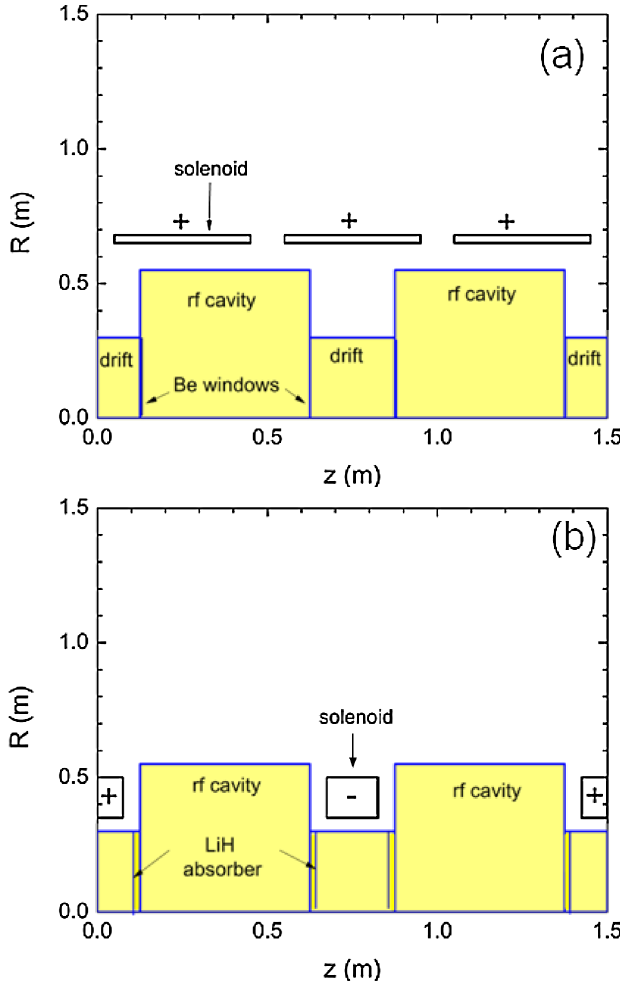
FIG. 2. Two cells of the baseline front-end system for a neu- trino factory with conventional pillbox cavities: (a) configuration for the buncher and rotator sections; (b) configuration for the cooling